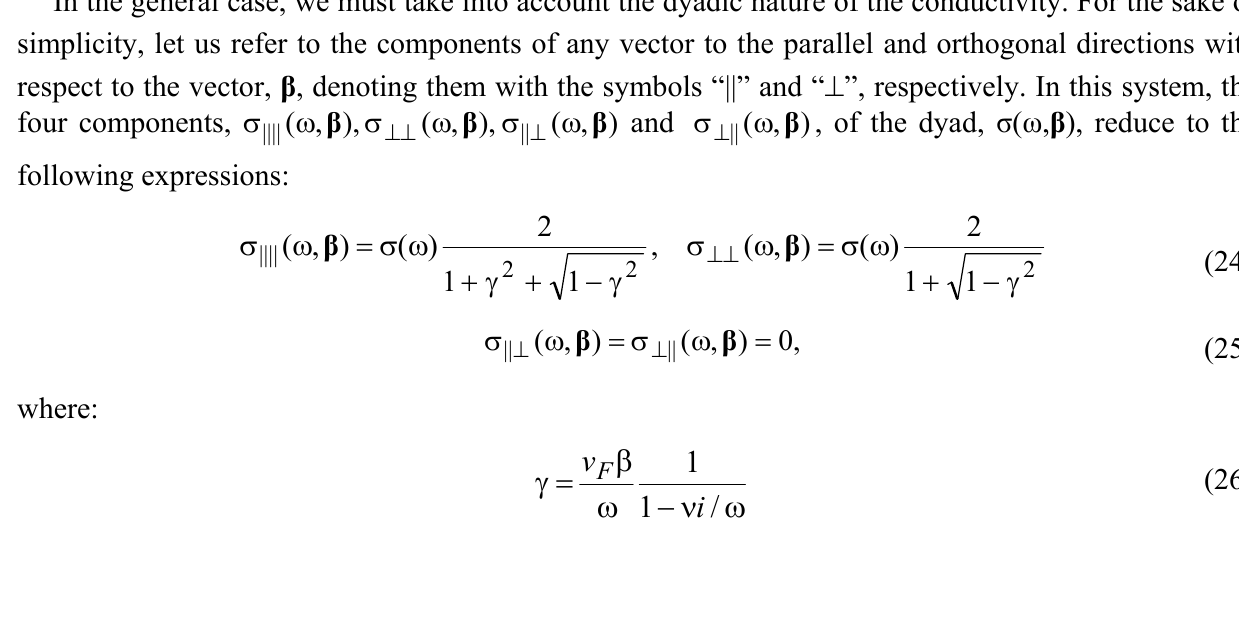
Figure 7. The ratio, σ